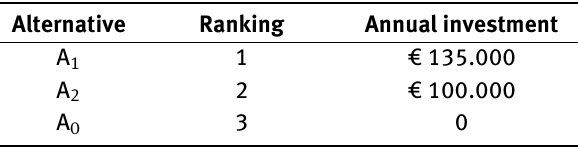
Table 3: Intervention alternatives ranking through multi-criteria